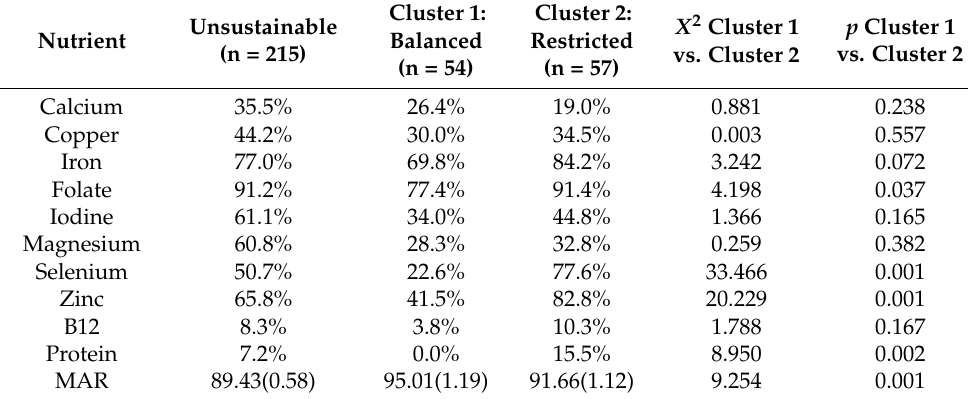
Table 2. Percentage of those in the two dietary clusters in the top tertial of the EAT–Lancet diet who consumed nutrient intakes below the